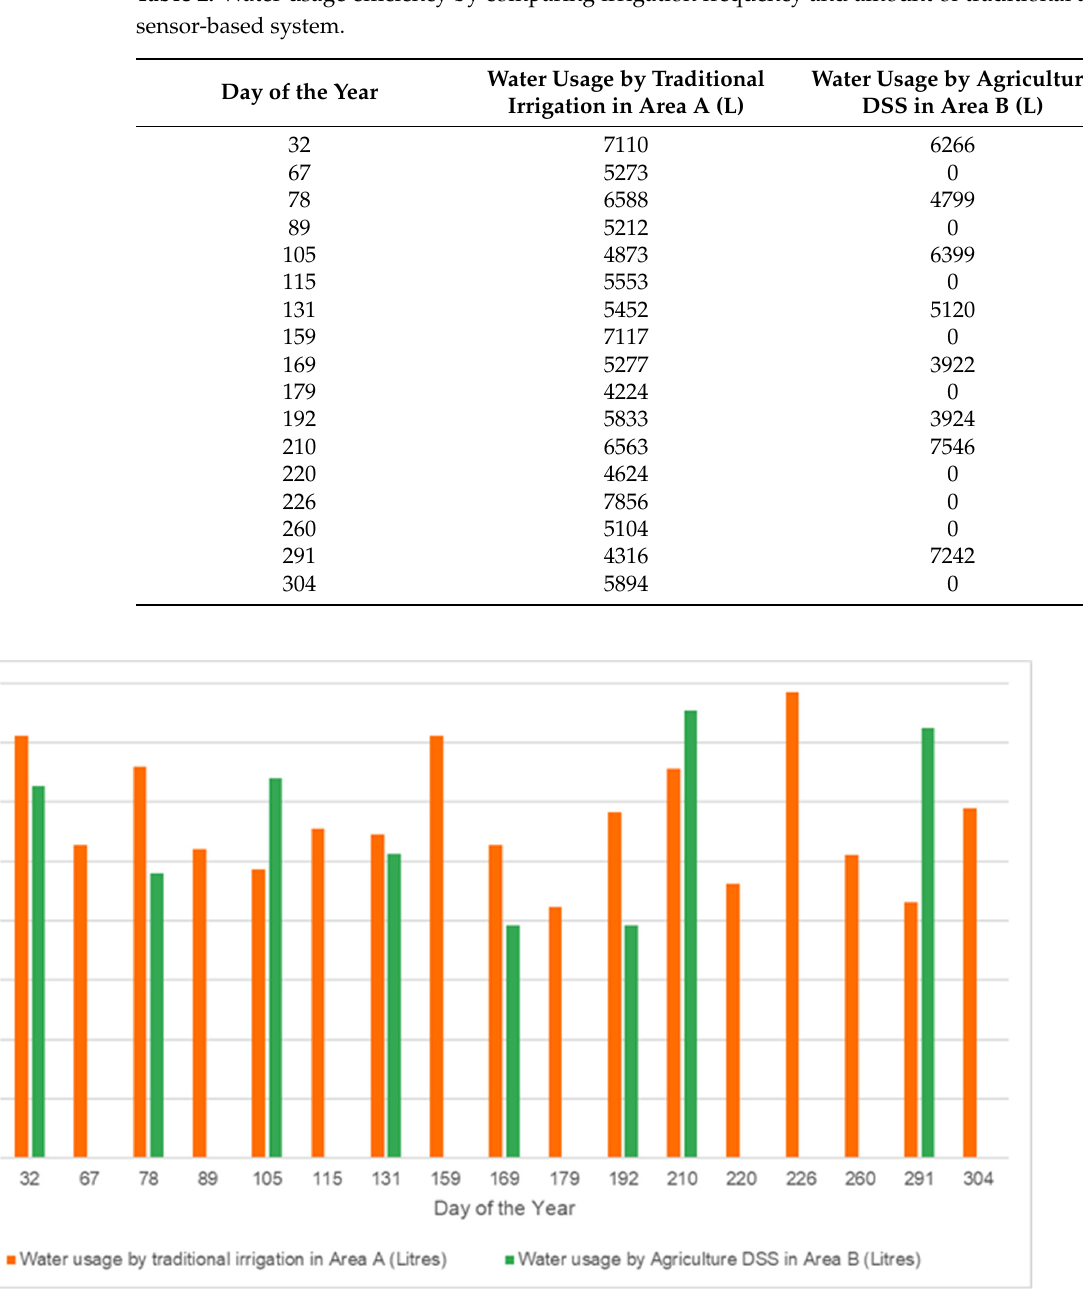
Table 2. Water usage efficiency by comparing irrigation frequency and amount of traditional and sensor-based system.